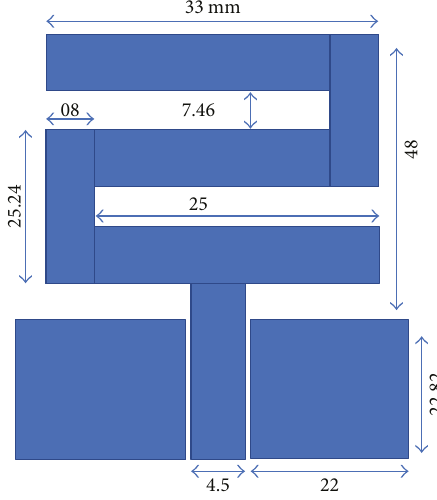
Figure 5: The dimensions of the CPW-fed Z-shaped